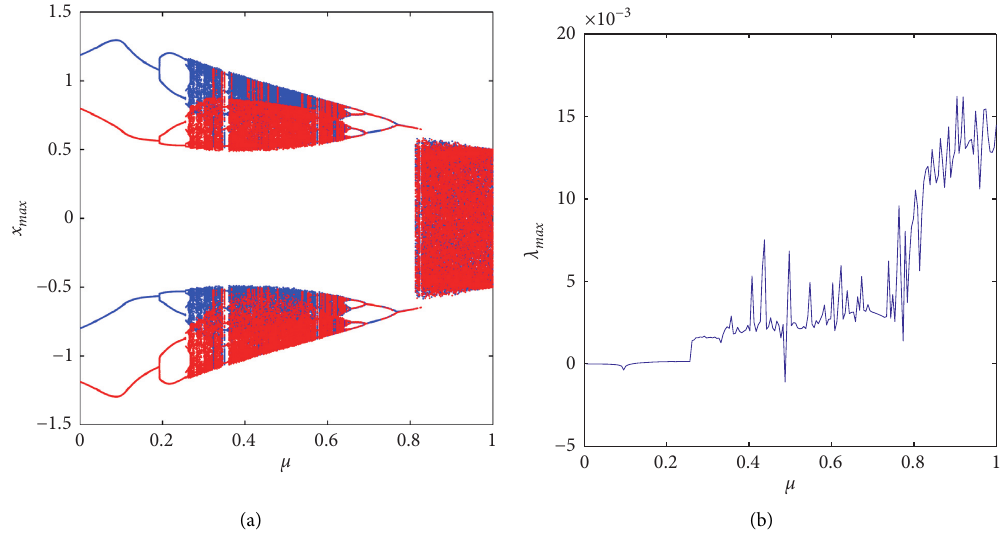
Figure 6: Bifurcation and maximum LE of system (8) versus μ depicted in (a) and (b), respectively, for parameters A � 0 . 5 , B � 0 , C � 3, and two symmetric initial conditions ( x